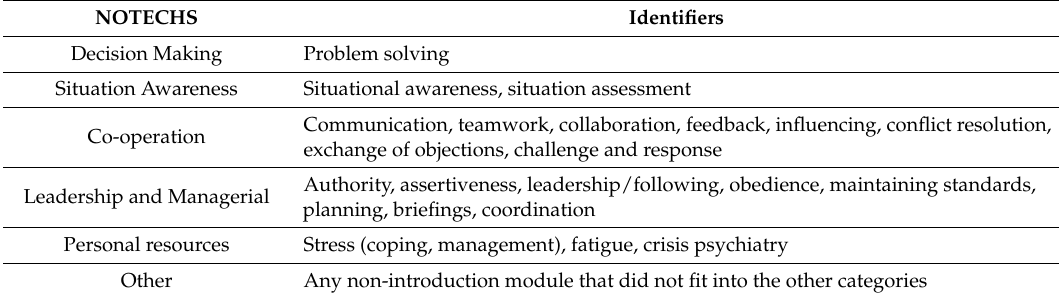
Table 1. NOTECHS classification for crew resource management (CRM)